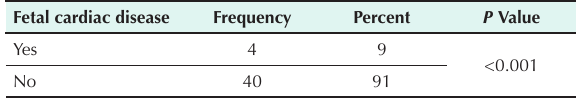
Table 1. Frequency of Fetal Cardiac Disease in Pregnant Women Fetal cardiac disease